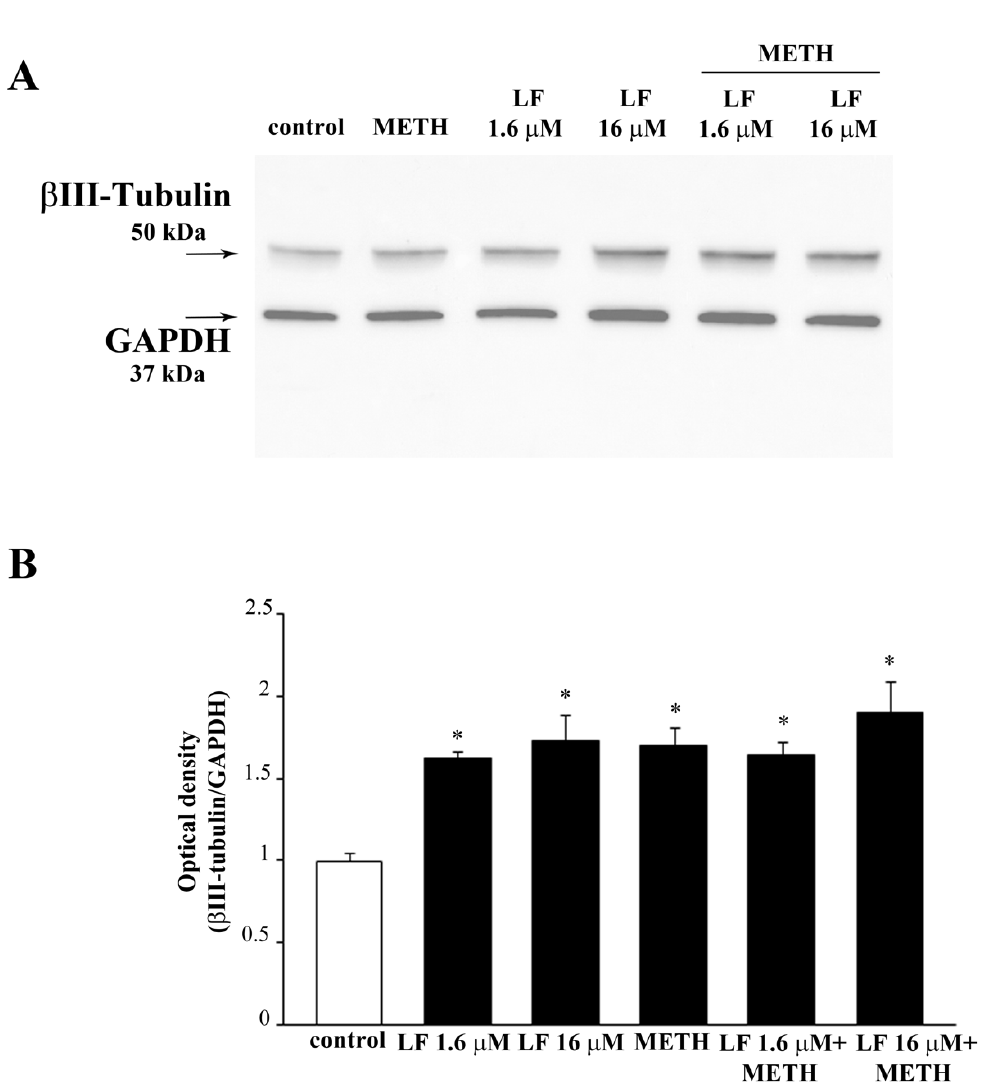
Figure 7. Representative β III-tubulin immuno-fluorescence. Representative pictures of β III-tubulin immuno-fluorescence after single and combined LF (1.6 μ M and 16 μ M) and METH administration. Arrows indicate β III-tubulin immuno-fluorescent cell branches. Scale bar = 16 μ M.